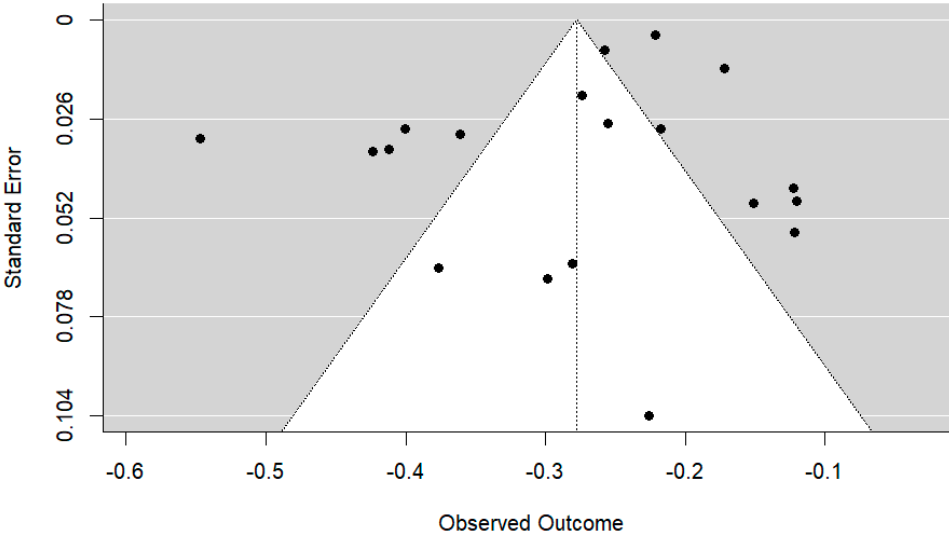
Figure 3. Funnel plot for assessing publication bias. The sensitivity analysis, performed using the jackknife method, did not show excessive individual influence of any of the studies on the estimated overall effect size, with the effect size ranging from Z r = − 0.26 to Z r = − 0.29 when alternately omitting each of the studies.